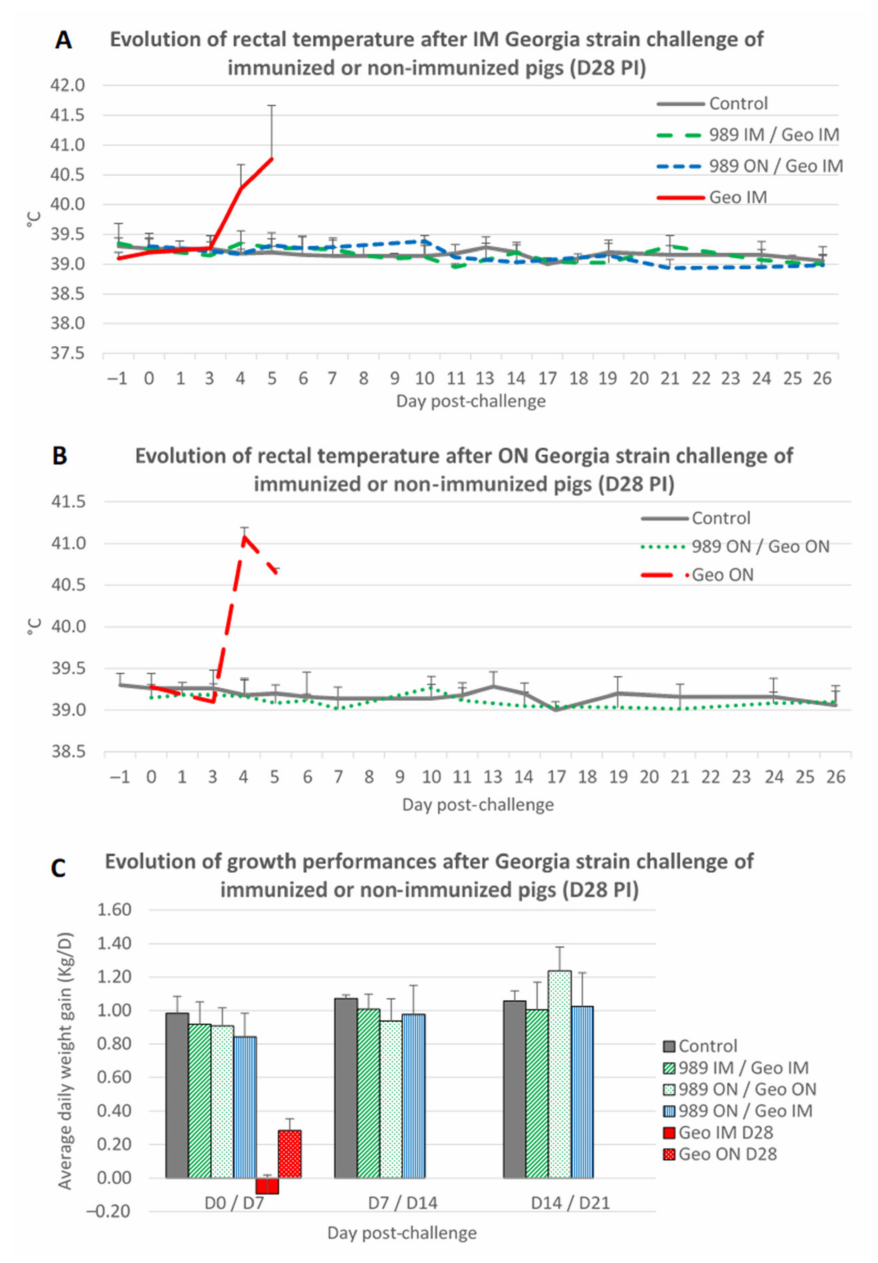
Figure 6. Evolution of rectal temperature and growth performance after Georgia challenge occurring 28 days after immunization. (A ) Evolution of rectal temperature ( ◦ C) after IM challenge with Georgia ASFV strain (time in days post-challenge). Control—data from group A2; 989 IM/Geo IM—data from group D; 989 ON/Geo IM—data from group I; Geo IM—data from group G. ( B ) Evolution of rectal temperature ( ◦ C) after ON challenge with Georgia ASFV strain (time in days post-challenge). Control—data from group A2; 989 ON/Geo ON—data from group H; Geo ON—data from group J. ( C ) Evolution of growth performance: average daily weight gain (Kg/D) after IM or ON challenge with Georgia ASFV strain (time in days post-challenge). Control—data from group A1 and A2; 989 IM/Geo IM—data from group D; 989 ON/Geo ON—data from group H; 989 ON/Geo IM—data from group I; Geo ON—data from group